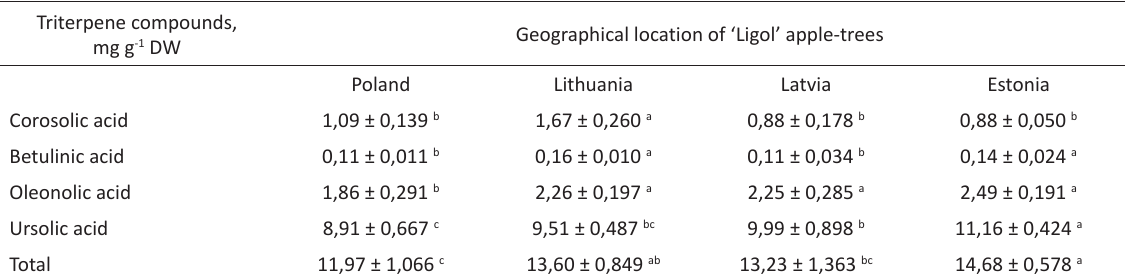
The different letters on the same line indicate statistically significant differences between the individual compounds in the apple samples ( p < 0.05).